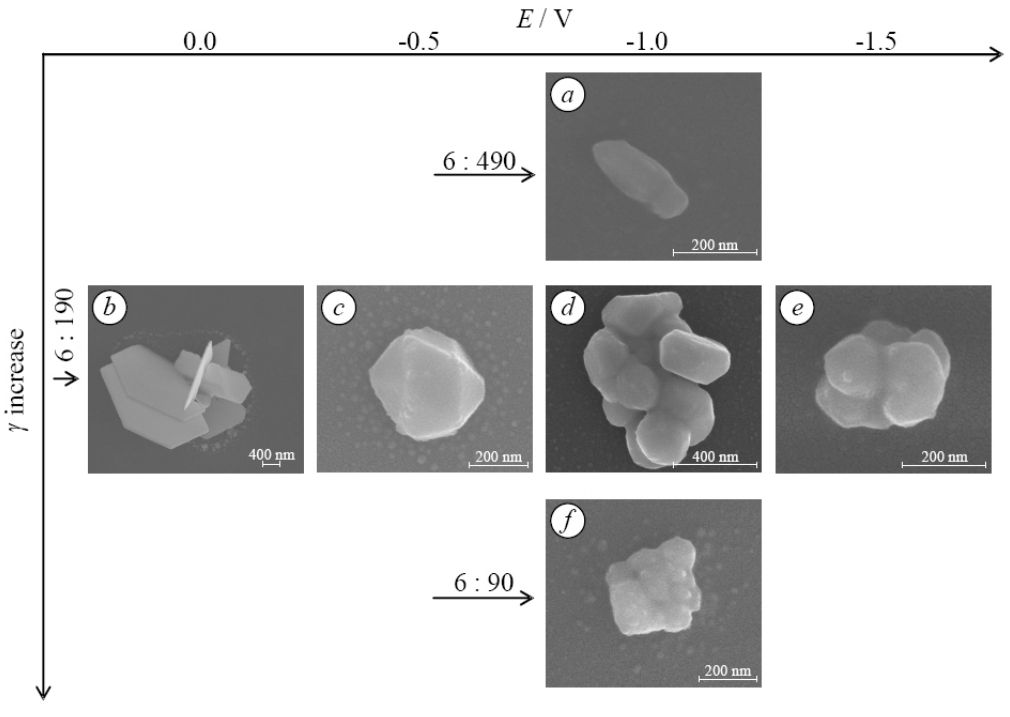
Figure 4. Conventionalized diagram about geometry of silver particles, deposited on ITO-glass surface in acetonitrile solution of 0.01 M AgNO by pulse electrolysis, depending on cathode potential, pulse duration and